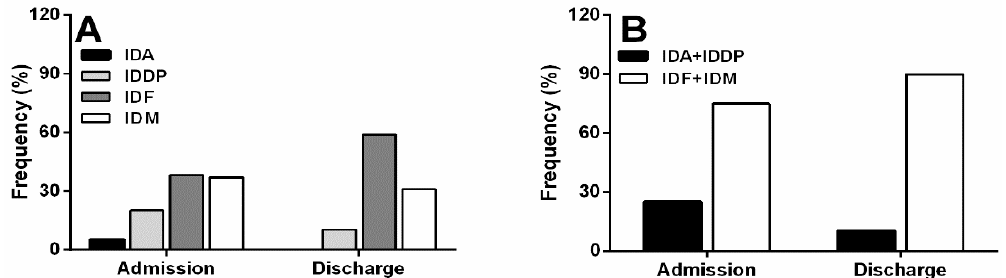
Figure 2. Percentage distribution of ( A ) the four different PIPs at admission and discharge and ( B ) the PIPs grouped as API-related PIPs (IDA + IDDP) and dosage form-related PIPs (IDF + IDM) at admission and discharge. Abbreviations: PIPs, potentially inappropriate prescriptions, API, active pharmaceutical ingredient; IDA, inappropriate drug association; IDDP, inappropriate drug for dysphagic patient; IDF, inappropriate dosage form for dysphagic patient; and IDM, inappropriate dosage form modification.